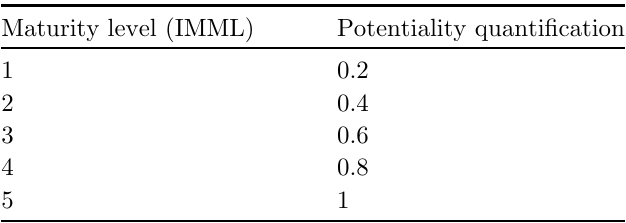
Table 2. Quanti fi cation of the maturity of the interoper- ability.